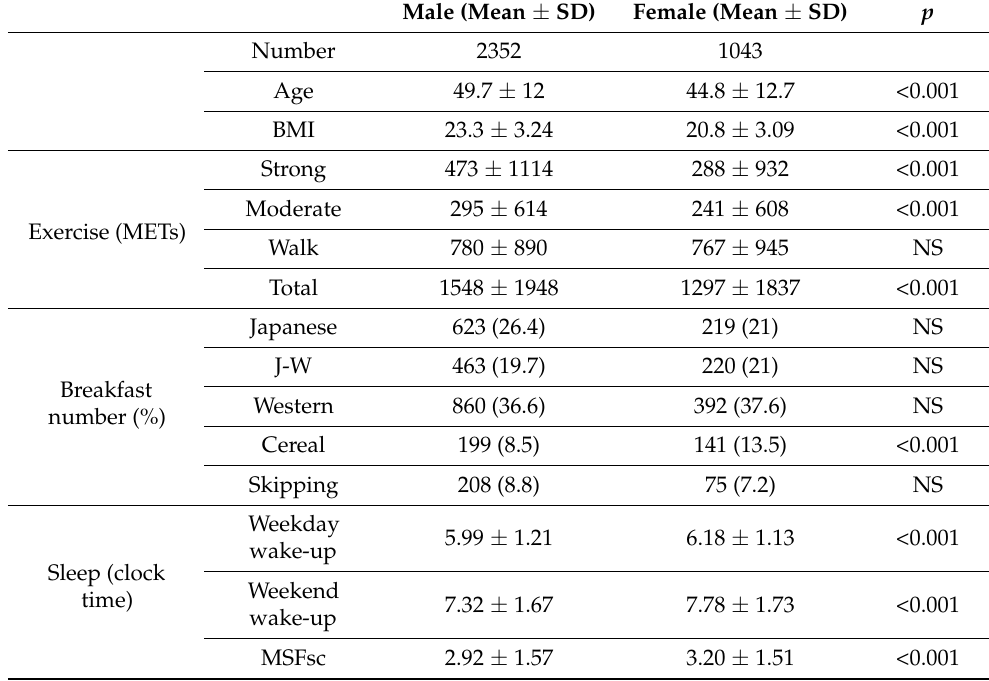
Table 1. Basic characteristics of participants.